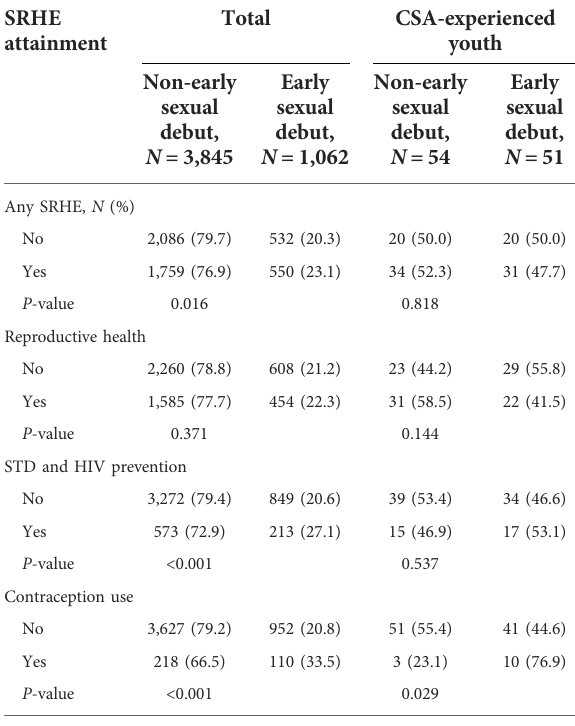
TABLE 3 Prevalence of early sexual debut by CSA experience and SRHE.